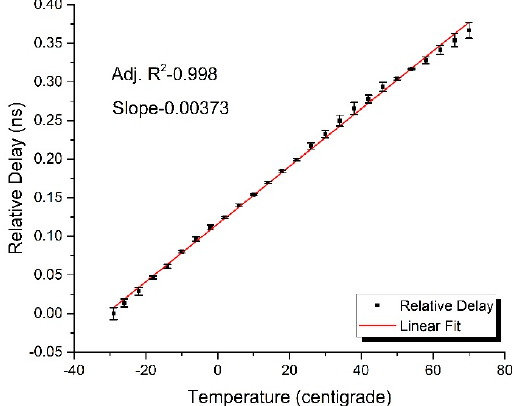
Figure 3. The experimental response of relative delay for the rise of temperature.